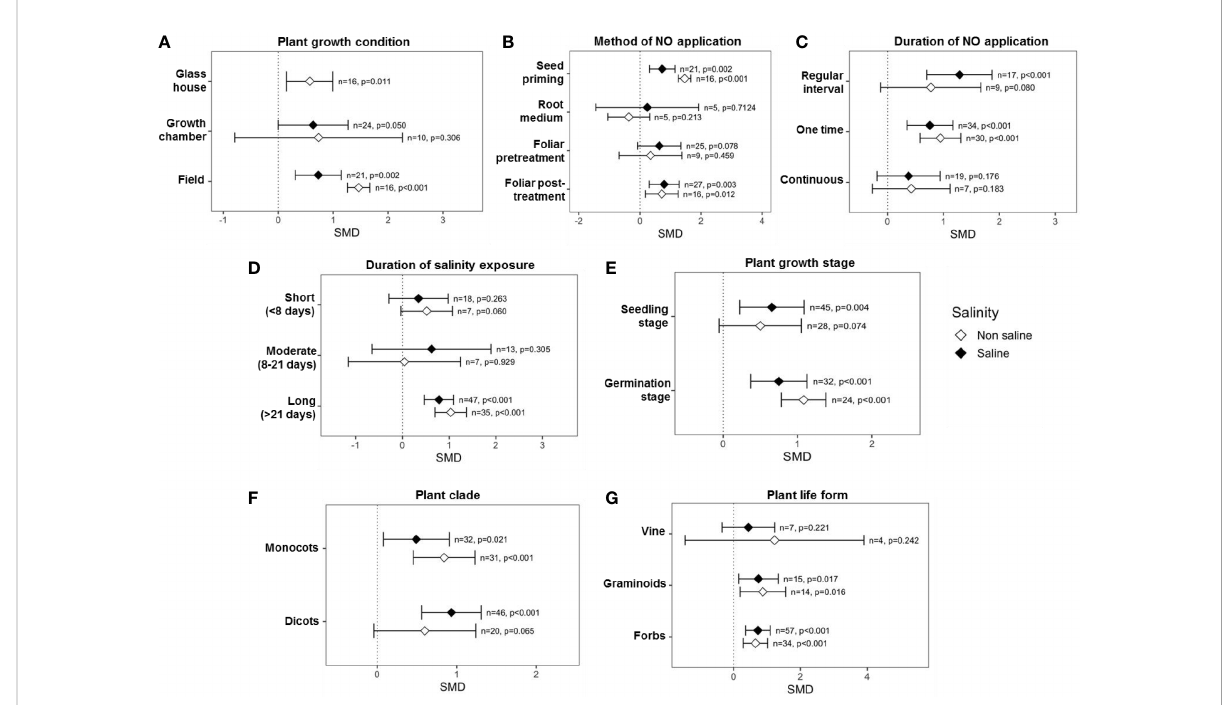
FIGURE 5 Effects of exogenous NO on RDW under saline and non-saline conditions for various categorical variables such as (A) growth conditions, (B) method of NO application, (C) duration of NO application, (D) duration of salinity, (E) plant growth stages, (F) plant clade, and (G) plant life form. The error bars are the effect size means ± 95% CIs. Where the CIs do not overlap the vertical dashed lines, the effect size for a parameter is signi fi cant, i.e., the growth responses of NO-treated plants were signi fi cantly different from those of non-NO-treated plants. n , the number of studies included in the meta-analysis; p , the signi fi cance level of